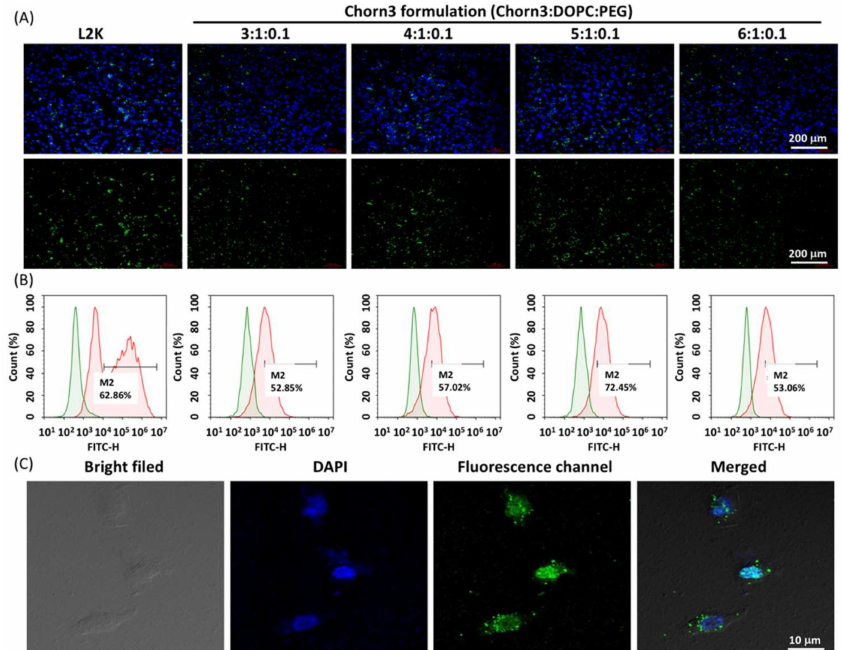
Figure 5. Measurement of cellular uptake of siRNA delivered by Chorn3 LNP. ( A ) Fluorescence microscopy observation of HeLa cells treated with FITC-labeled siRNA complexed to lipofectamine 2000, or di ff erent formulations of Chorn3 LNP; ( B ) quantification of FITC-positive cells by flow cytometry; ( C ) confocal images of HeLa cells transfected with FITC-labeled siRNA complexed to Chorn3 formulation (5:1:0.1). Image size: 100 × 100 µ